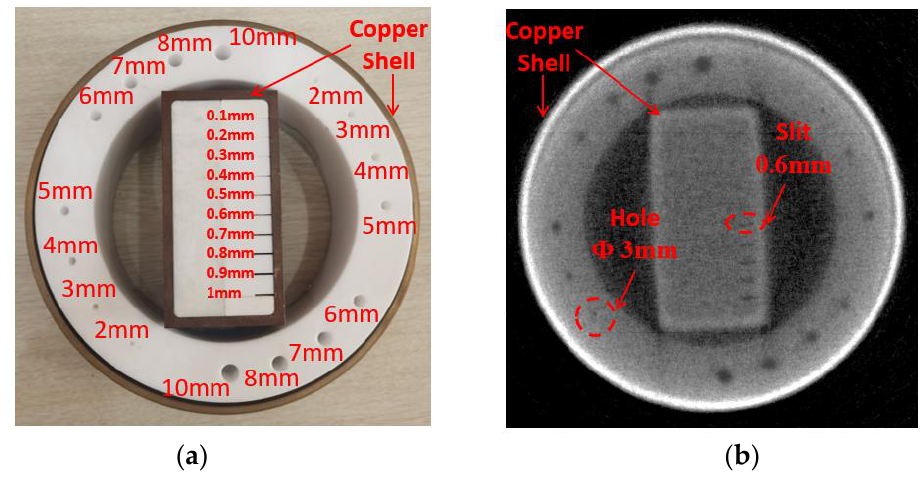
Figure 12. Sample and reconstructed image of fast tomography. ( a ) Sample of fast neutron tomography; ( b ) Reconstructed slice image.